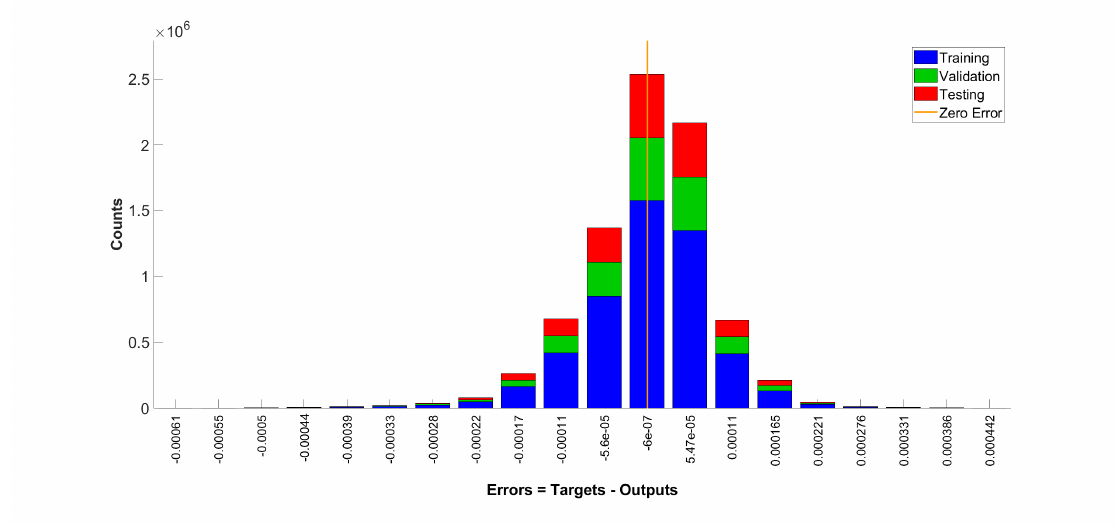
Figure 3. Error distribution histogram for training, validation, and testing